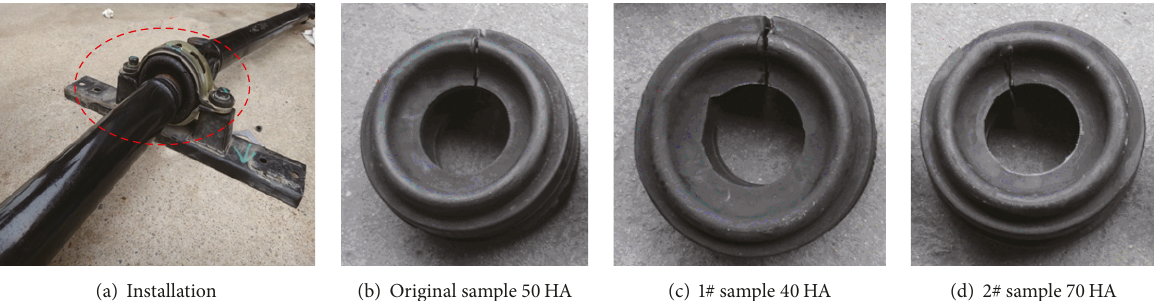
Figure 19: Samples of transmission shaft support bushing.